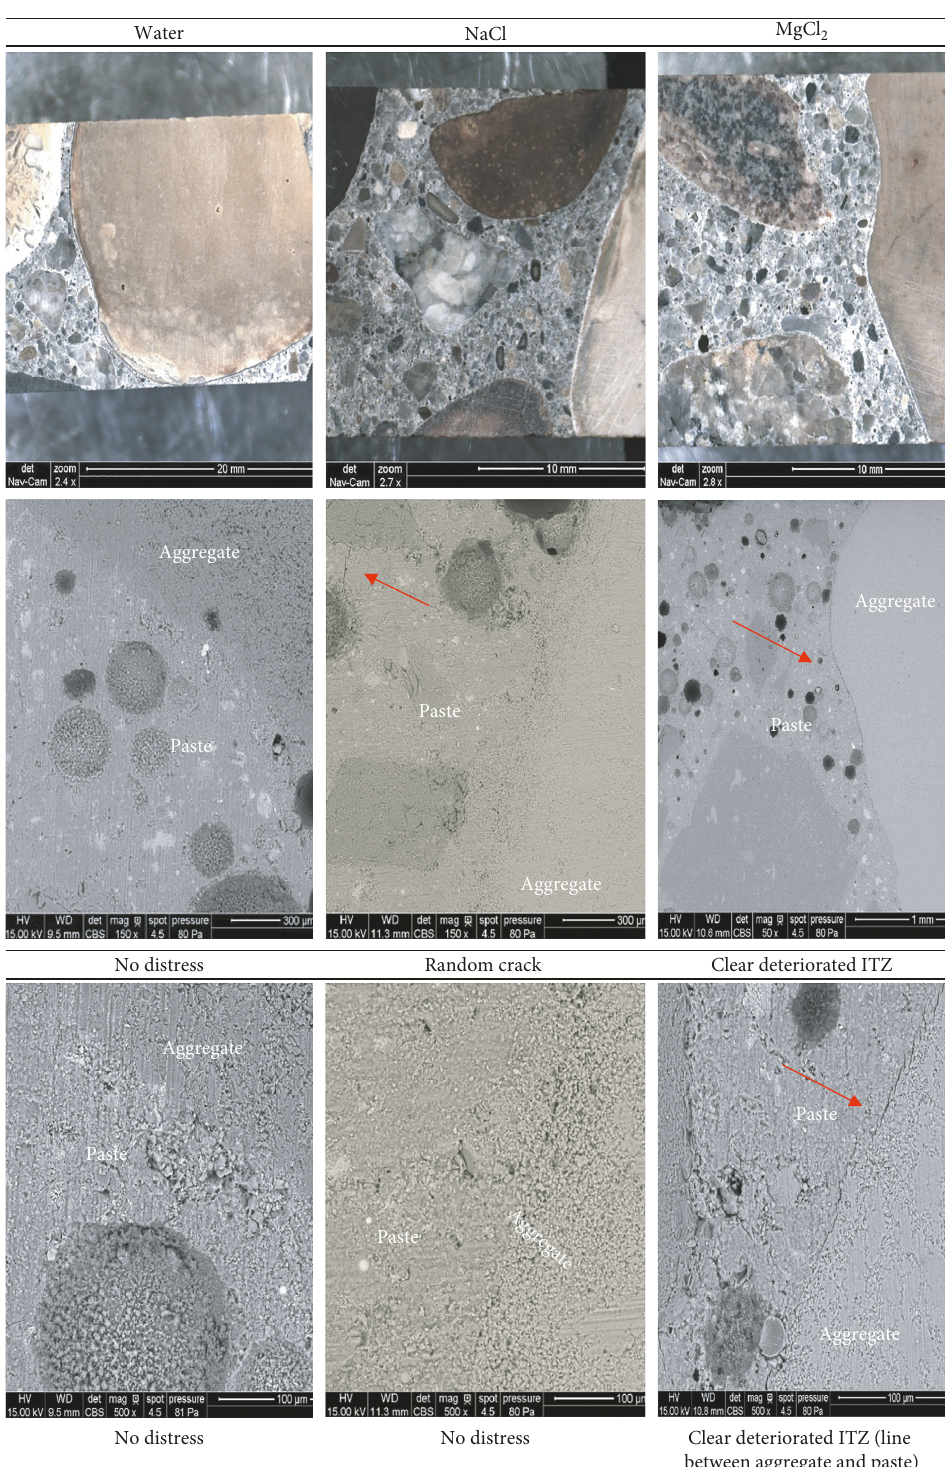
Figure 8: SEM images of sample soaked in water, NaCl, and MgCl